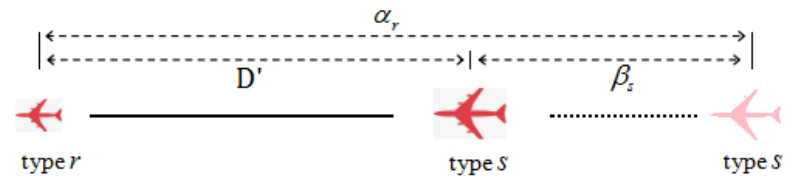
Figure 2. The division of MST